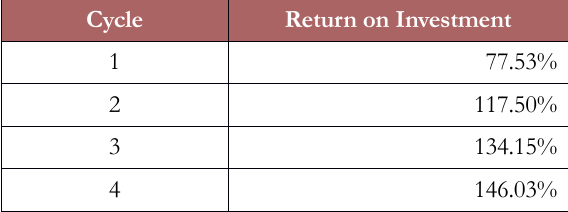
Table 30. Effects of learning cycle to the ROI